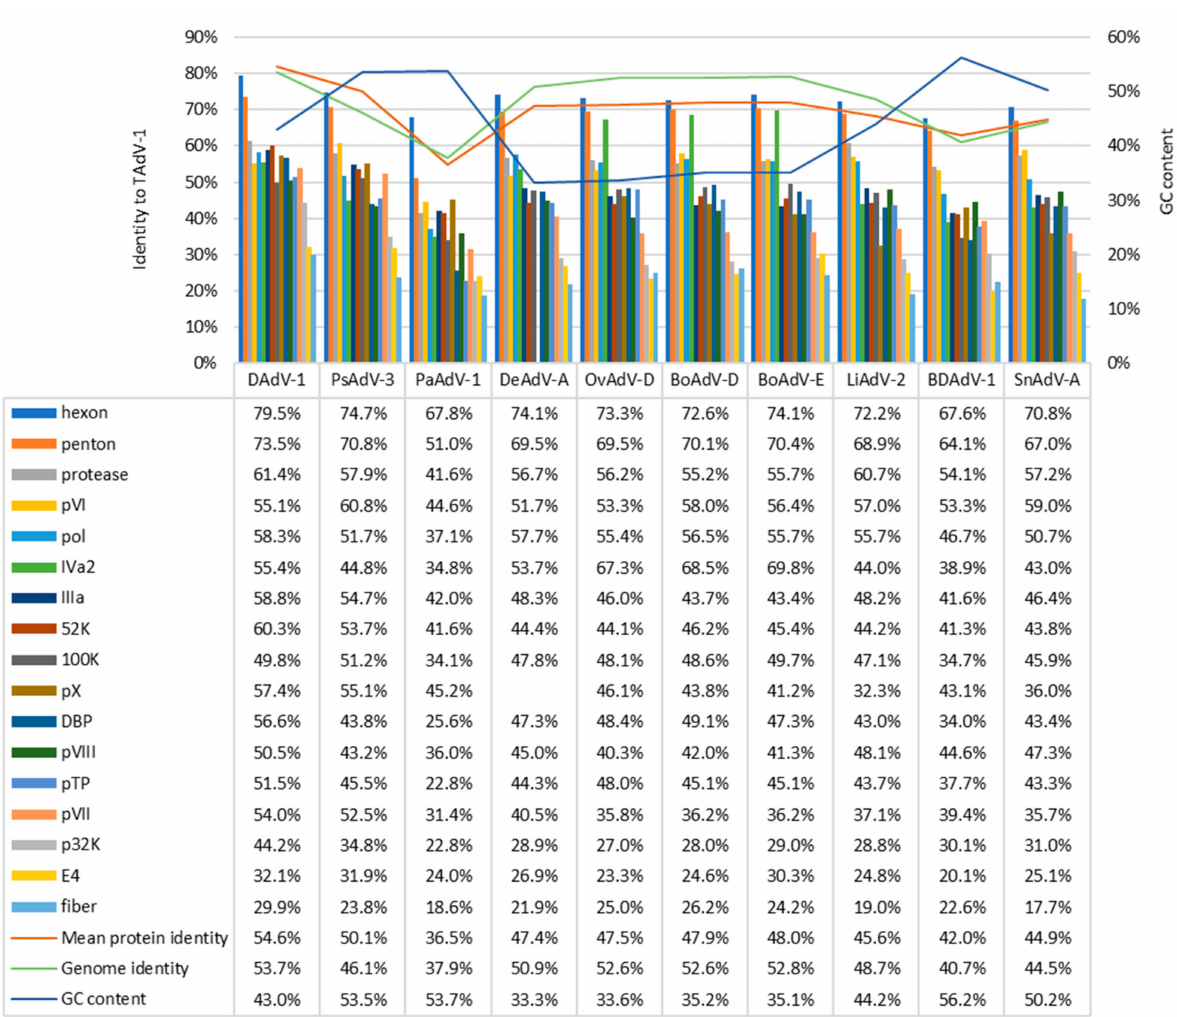
Figure 1. Schematic view of the TeAdv-1 genome structure. Genes and ORFs are illustrated as arrows pointing in the direction of transcription. Green indicates a conserved set of genes present in the genomes of AdVs. Genes that are found in the genomes of more than one genus of AdVs, including the genus Atadenovirus , are shown in blue. Genes specific to Atadenovirus are highlighted in yellow. Specific for TeAdV-1 genes colored red.